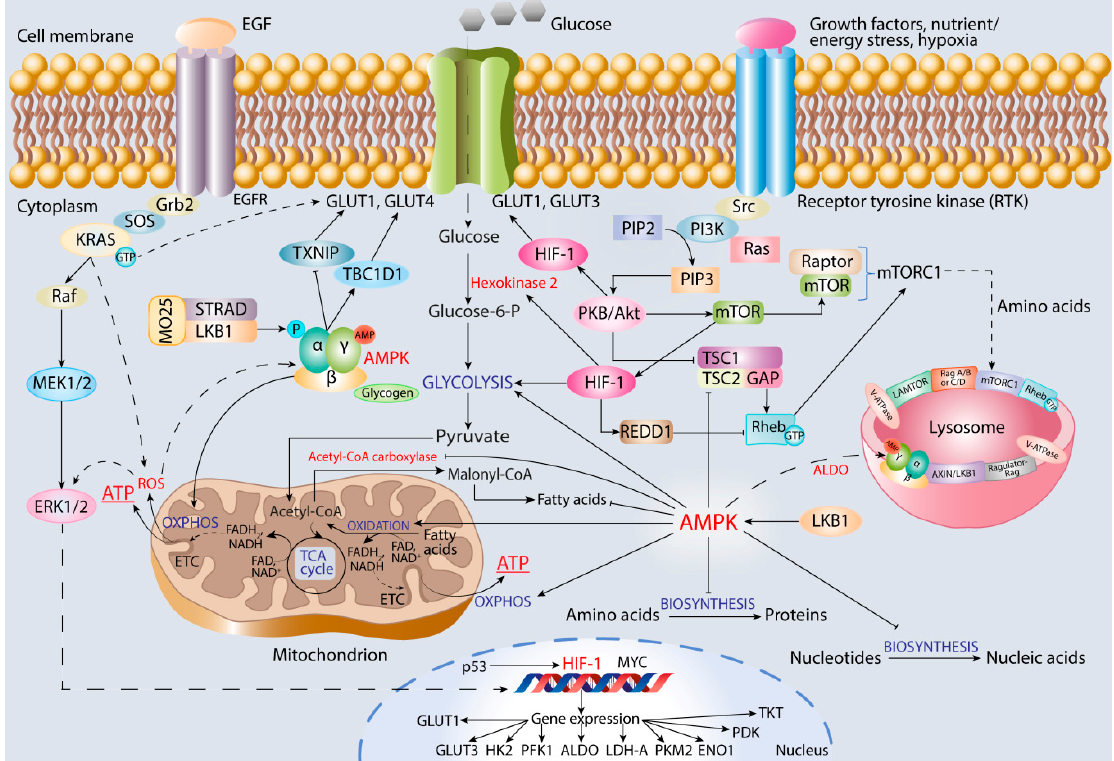
Figure 3. Interplay between AMPK-, HIF-1-, and ROS-regulated growth factor/nutrient and energy stress/hypoxia-initiated cell signaling pathways in controlling both glycolysis and OXPHOS to produce ATP for cancer cell proliferation, invasion, and migration. The involvement of AMPK in lysosomal complex formation is also shown.